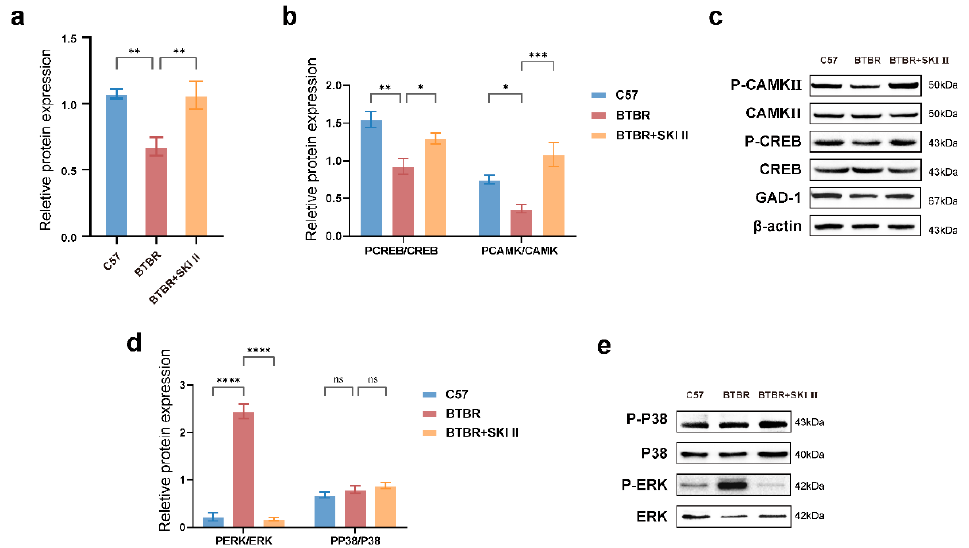
Figure 7. ApoA-I-related pathway regulates the expression of proteins related to anxiety, cogni- tion and spatial learning function, as well as the MAPK pathway in the hippocampus of the mice. ( a , b ) Representative Western blotting bands and quantification of the anxiety-related protein GAD1/ β -actin ratios. ( a , c ) Representative Western blotting bands and quantification of the cognition- and spatial learning-related proteins (P-CaMKII)/CaMKII, (P-CREB)/CREB ratios. ( d , e ) Repre- sentative Western blotting bands and quantification of the MAPK pathway protein P-P38/P38, P-ERK/ERK ratios. N = 8 per group. All data are shown in bar diagrams, which reflect the arithmetic mean ± standard error of the mean. * p < 0.05, ** p < 0.01, *** p < 0.001, **** p <